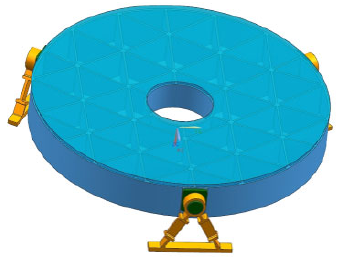
Fig. 8 Three-point peripheral bipod support around the mirror.